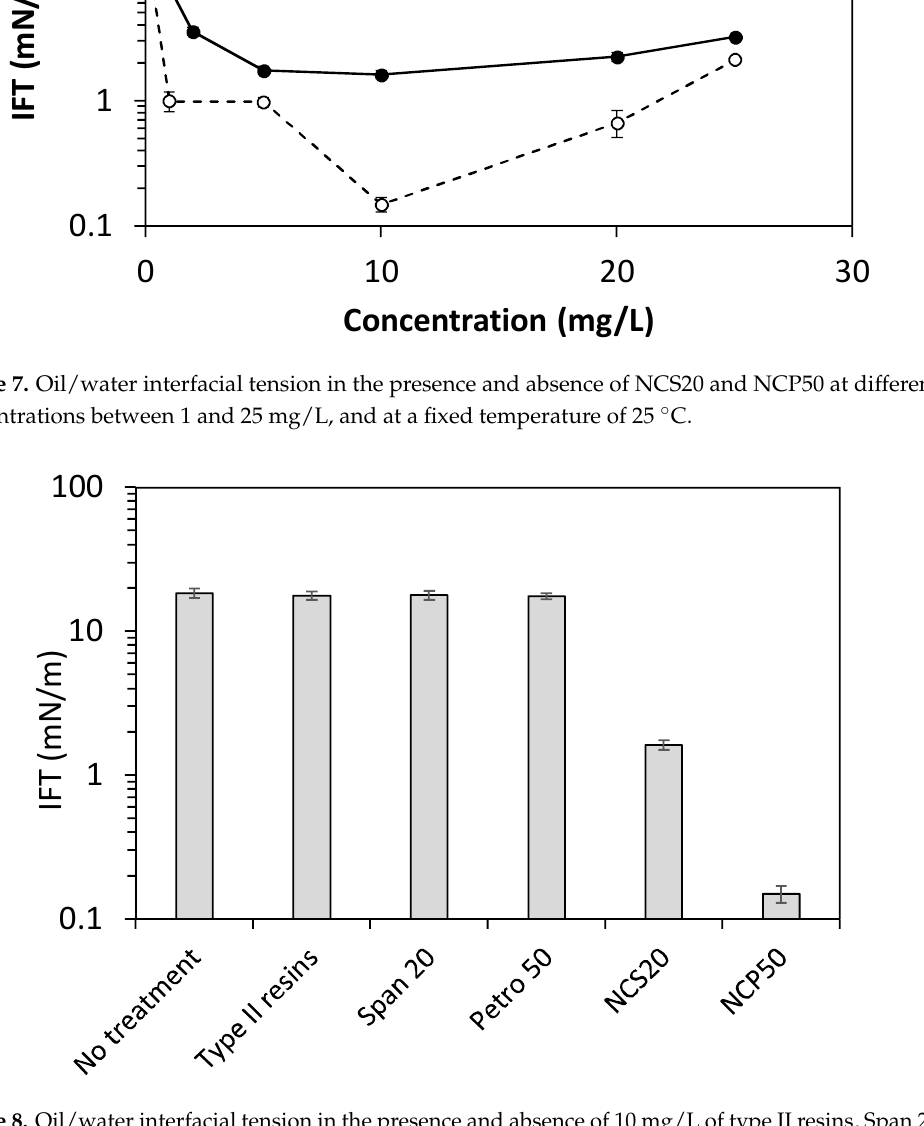
Figure 8. Oil/water interfacial tension in the presence and absence of 10 mg/L of type II resins, Span 20 surfactant, Petro 50 surfactant, NCS20, and NCP50 at a fixed temperature of 25 °C.